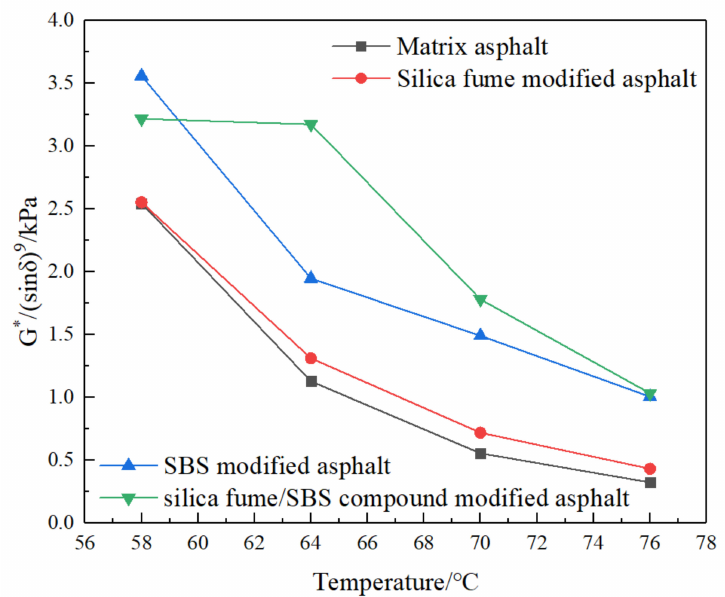
Figure 6. Curves of G * / (sin δ ) 9 of four kinds of asphalt with